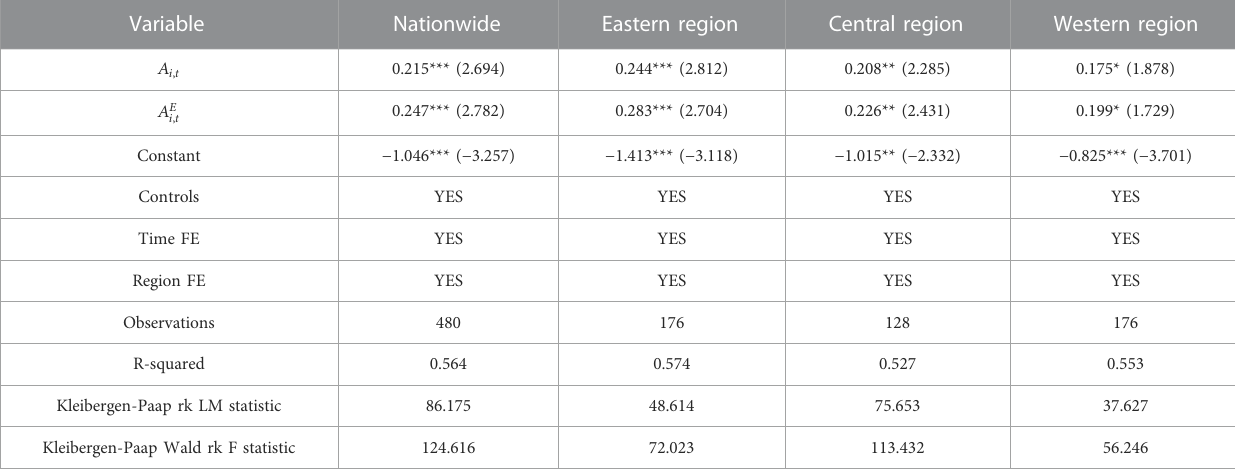
TABLE 9 Regression results of instrumental variable method.